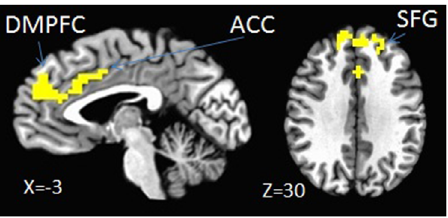
Figure 3. Conjunction analysis of the brain activation patterns of SN and MN compared with those of UN reveals that the MPFC, ACC, and SFG are activated both in SN and MN